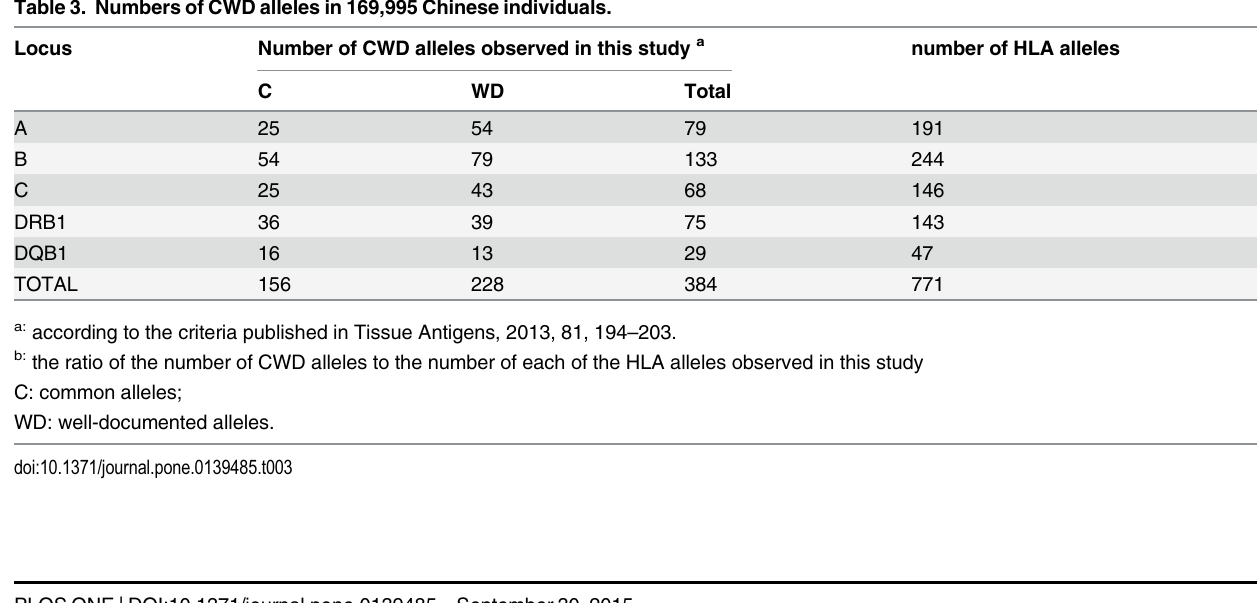
Hardy-Weinberg exact tests were performed on each of the five loci. The corresponding p